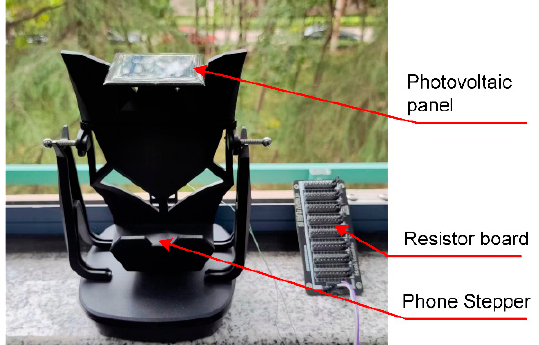
Figure 5. Experimental measurements of micro-power photovoltaic panels under dynamic condi- tion.